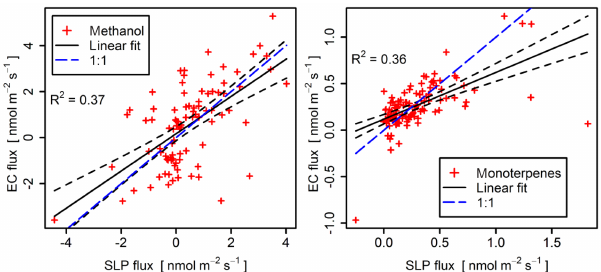
Figure 10. The eddy covariance fluxes against the surface layer gra- dient fluxes (methanol and monoterpenes, April–June 2013). In ad- dition to the actual scatter plots, the figures include linear fits (black solid lines) with confidence intervals (black dashed lines) and R 2